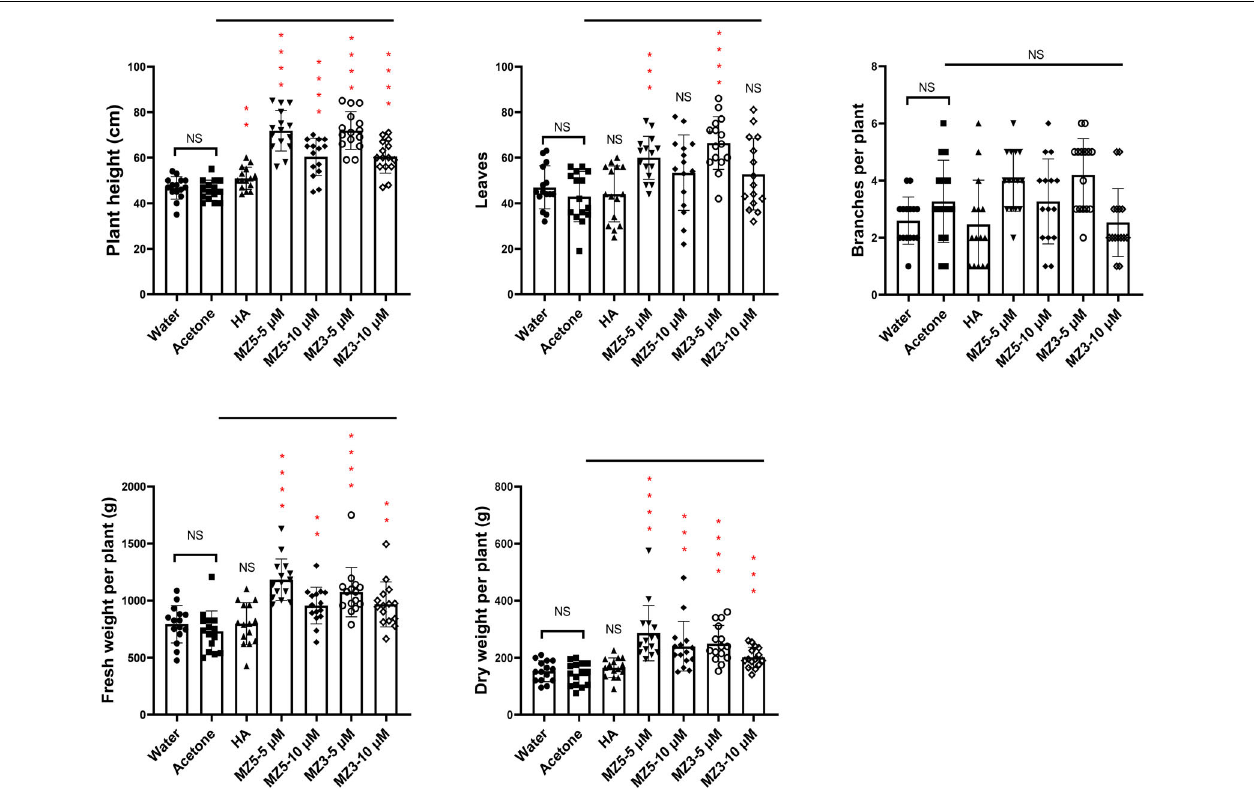
FIGURE 8 | Plant phenotypical evaluation of MiZax on squash from the field of the KAU, performed in 2021. MiZax effect on crop production from the field of the KAU in 2021 ( n = 15). Statistical analysis was performed using the two-tailed Student’s t -test. Asterisks indicate statistically significant differences as compared to CTL (** p < 0.01, *** p < 0.001, **** p < 0.0001). Symbols ( • , CTL; (cid:4) , Acetone; (cid:78) ,1.5 g L − 1 HA; (cid:72) , 5 µ M MZ5; (cid:7) , 10 µ M